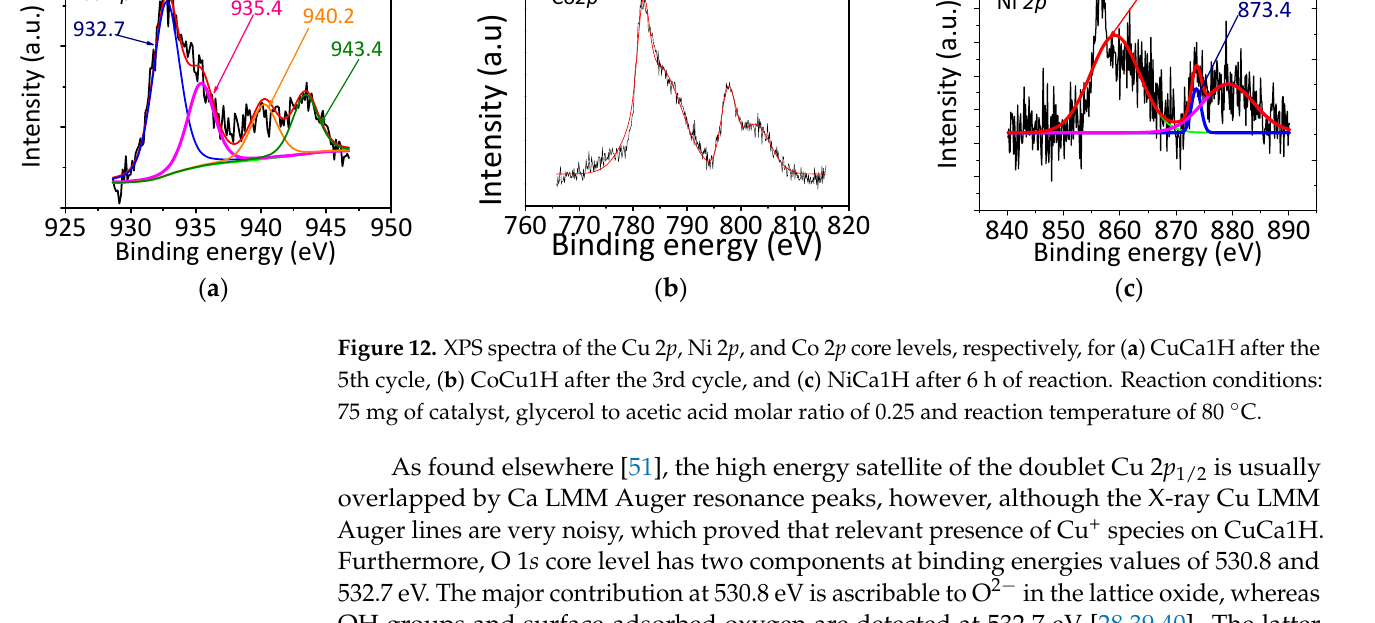
Figure 13. XPS spectra of the C 1s for ( a ) CuCa1H after the 5th cycle, ( b ) CoCu1H after the 3rd cy- cle, and ( c ) NiCa1H after 6 h of reaction. Reaction conditions: 75 mg of catalyst, glycerol to acetic acid molar ratio of 0.25, and reaction temperature of 80 °C.